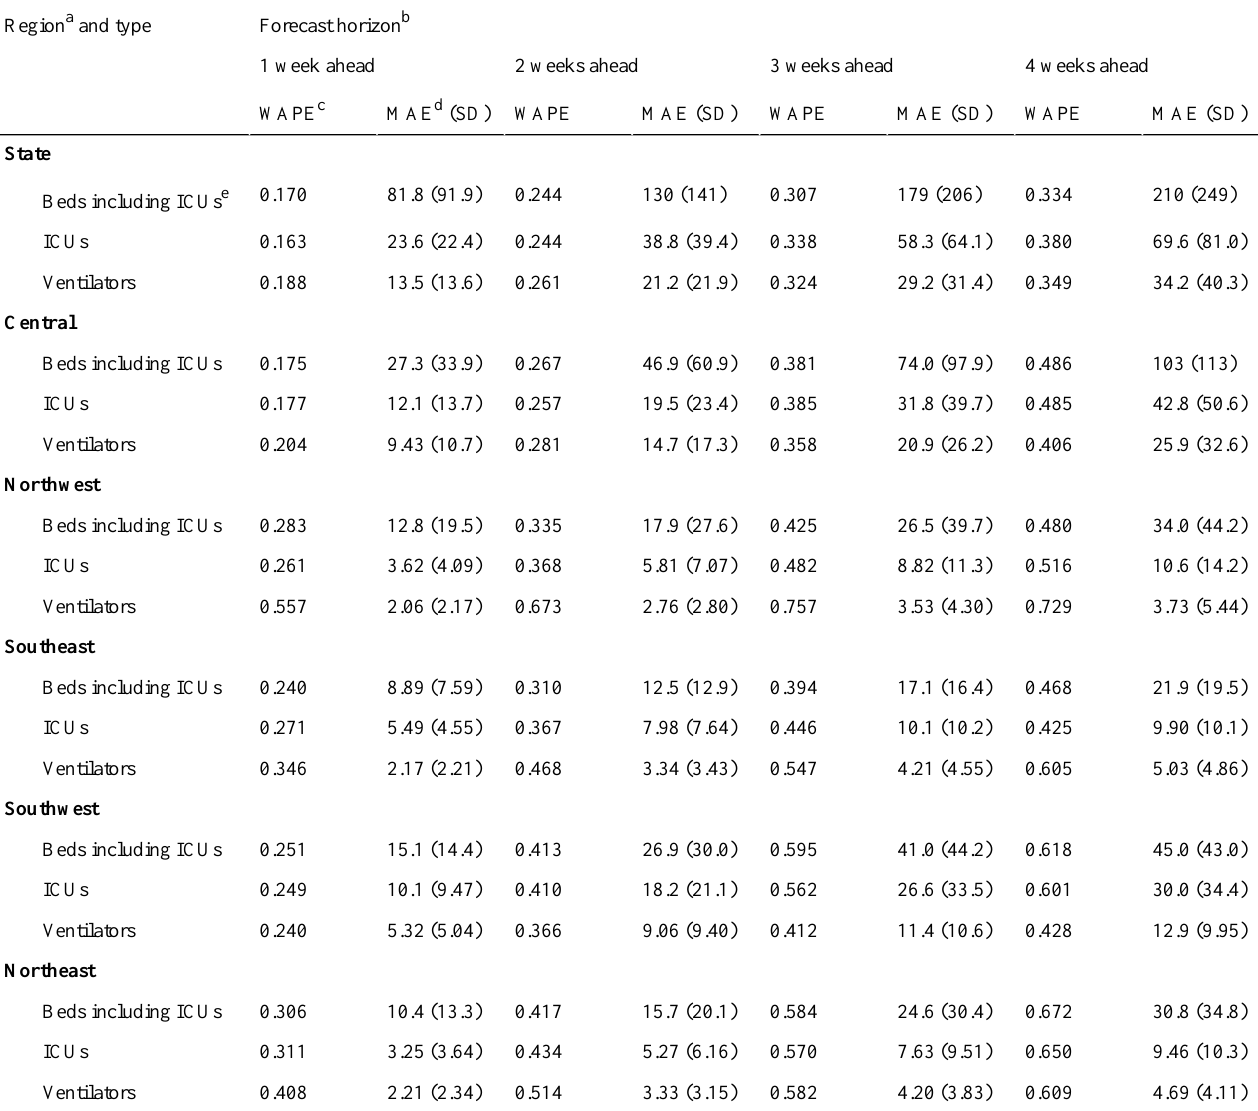
Table 2. The WAPEs and MAEs of the predicted forecasted median for COVID-19 health care use numbers reported for September 1 to January 5, 2020, in New